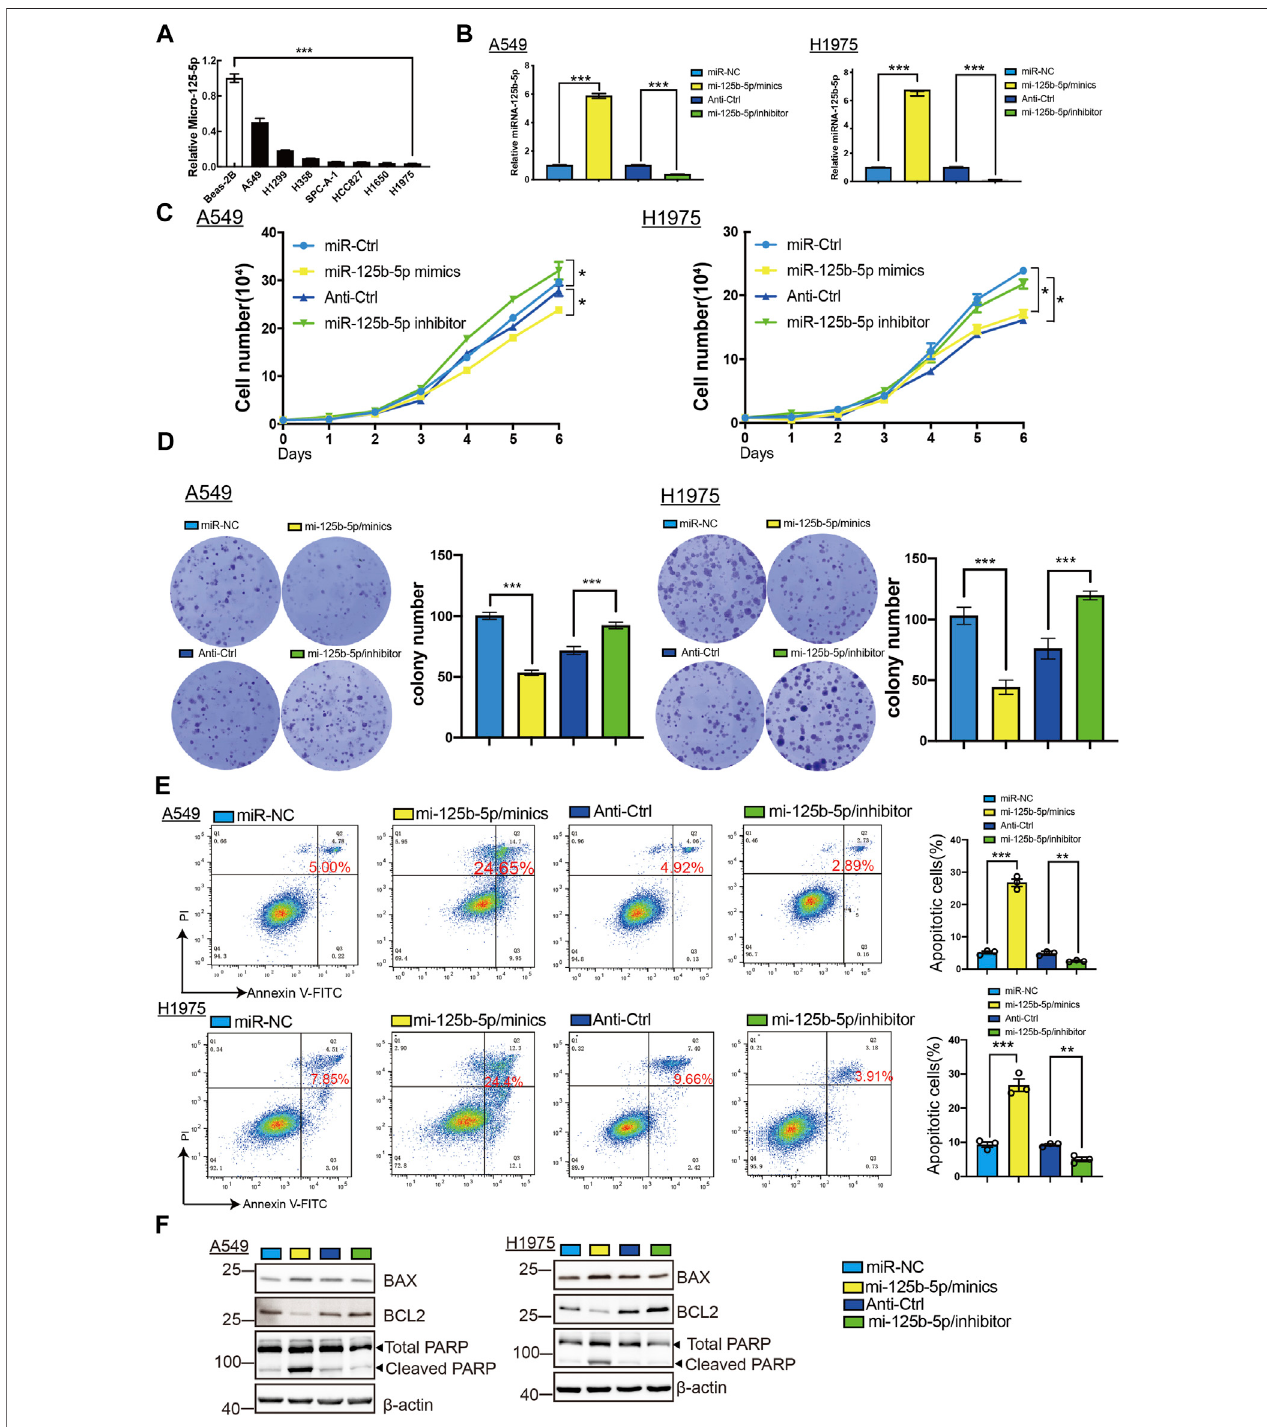
FIGURE 6 | Overexpression of miR-125b-5p inhibited lung adenocarcinoma (LUAD) cell proliferation. (A) Expression of miR-125b-5p in LUAD cell lines examined bythequantitativereal-timePCR(qRT-PCR)assay. (B) ExpressionofmiR-125b-5pinLUADcelllinesafteritsoverexpressionexaminedusingtheqRT-PCRassay. (C,D) Overexpression of miR-125b-5p on cell growth ability examined using the growth curve and colony formation assays. Scale bar, 50 μ m. (E,F) Overexpression of miR- 125b-5p on cell apoptosis examined by fl ow cytometry and Western blot assay. Quanti fi cation data are also indicated. * p < 0.05, ** p < 0.01, *** p < 0.001.